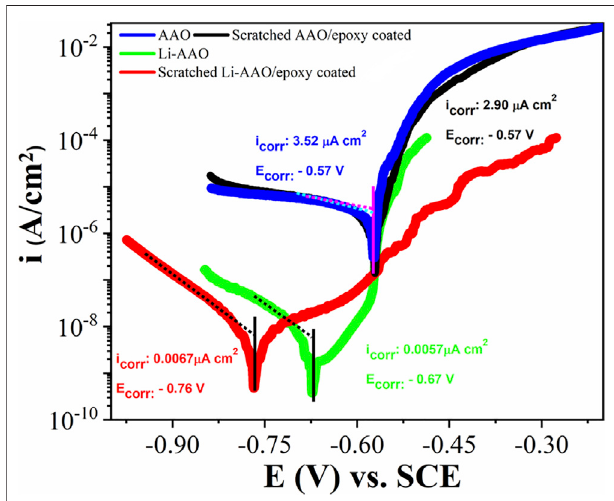
FIGURE 5 | Potentiodynamic polarization curves of the AAO substrate, Li-AAO substrate, scratched AAO/epoxy coating, and scratched Li-AAO/ epoxy coating.